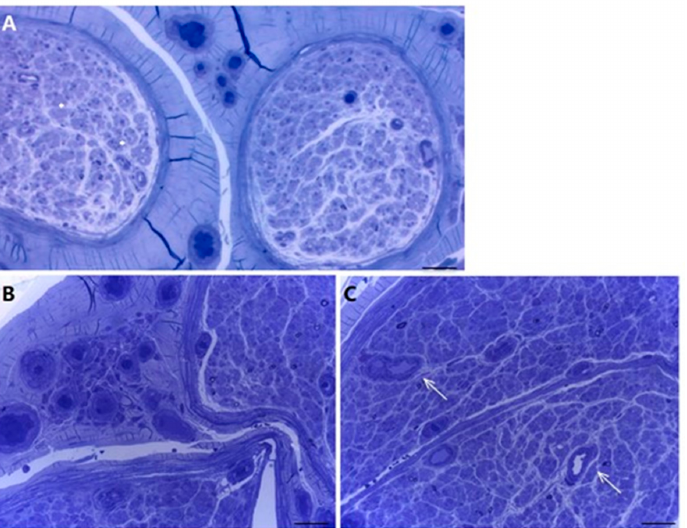
Figure 5. Sural nerve biopsy from a patient with POEMS syndrome. ( A ) Severe loss of myelinated fibers and occasional early remyelinating fibers (*) are observed (semithin section, toluidine blue, original magnification 20×; bar 100 μ m). ( B ) Epineurial capillaries are surrounded by slight lym- phomonocytic infiltrates (semithin section, toluidine blue, original magnification 40×; bar 100 μ m). ( C ) Endothelial proliferation of endoneurial vessels is evident (arrows) (semithin section, toluidine blue, original magnification 40×; bar 100 μ m). Chemotherapy-induced peripheral nerve involvement, a dose-limiting effect possi- bly leading to treatment discontinuation, is common in the context of hematological dis-